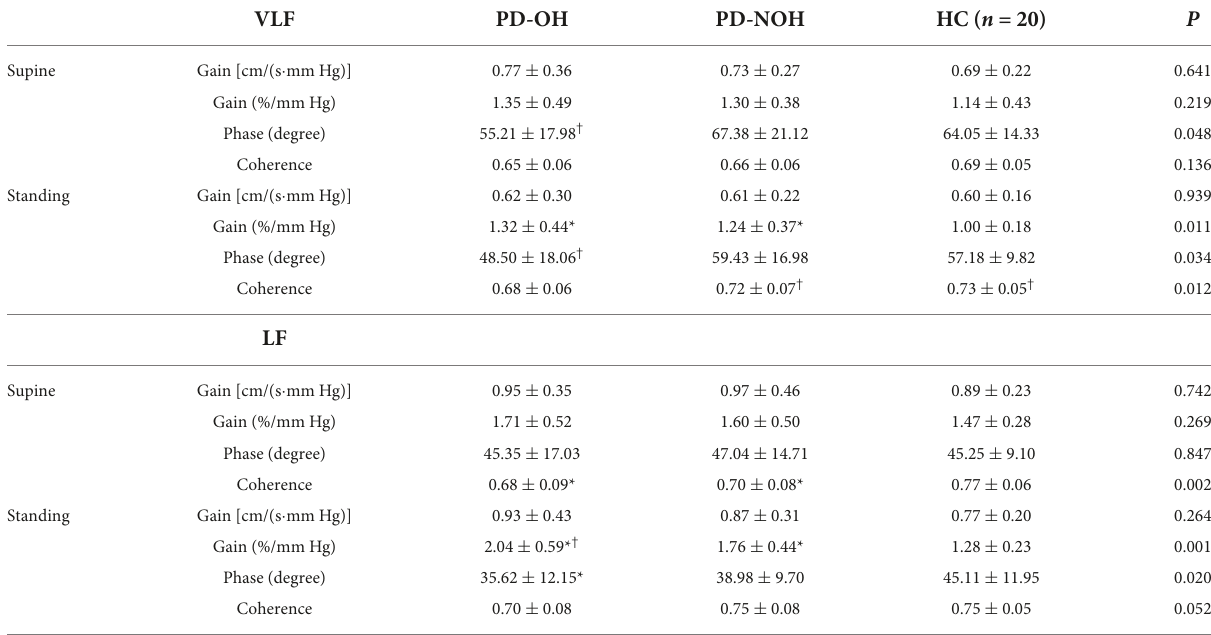
TABLE 4 Comparison of cerebral autoregulation parameters in each group.